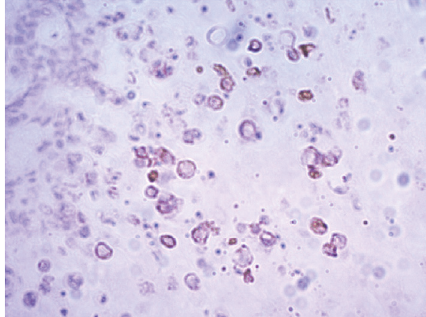
Figure 1: H&E staining viewed under × 40 showing a bladder carcinoma composed of mucinous and signet-ring cell components, showing nests of columnar cells and signet-ring cells floating in pools of extracellular mucin.